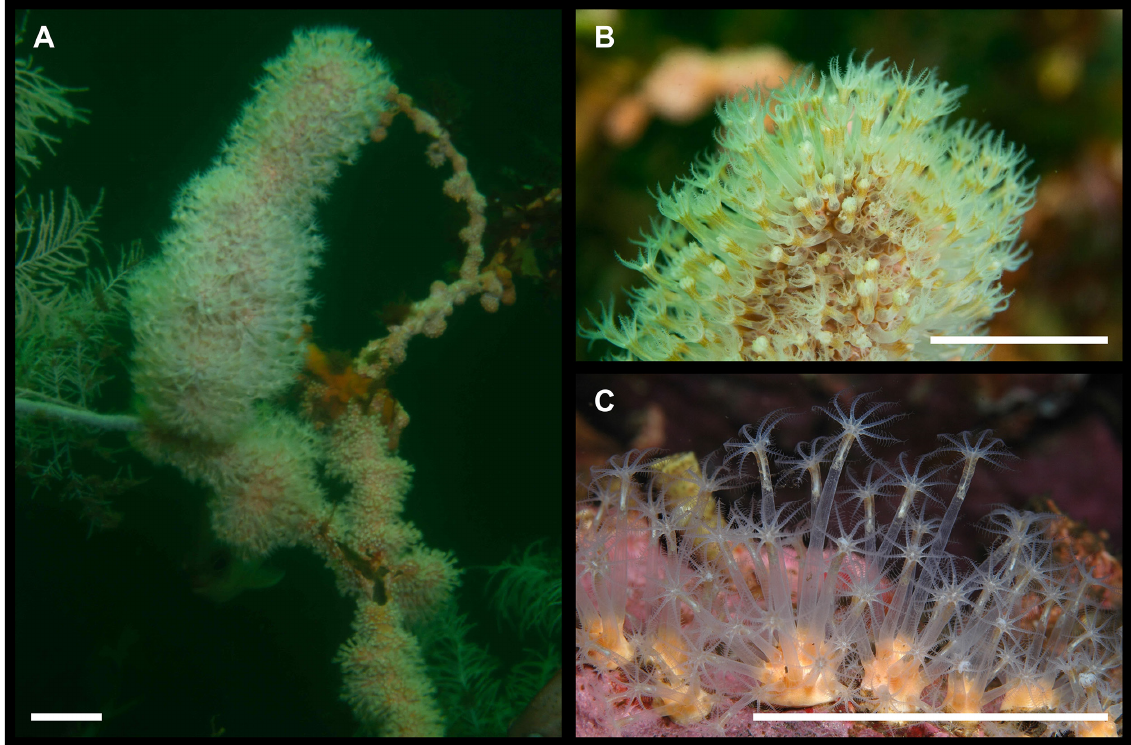
Fig. 31. In situ photographs of Ushanaia fervens gen. et sp. nov. A–B . Encrusting on black coral (uncollected specimen), Fiordland, photos by Richard Kinsey. C . Small colonies (uncollected specimens), Fiordland, photo by Ian Skipworth (ianskipworth.com). Scale bars = ~2